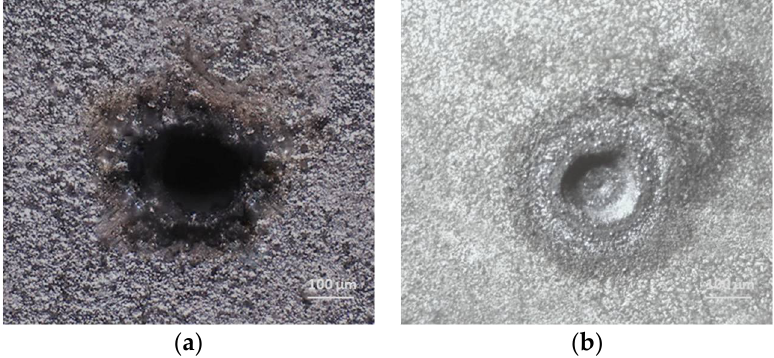
Figure 10. Micromachined cavities in the smart material using the LA-LBMM process under ( a ) distilled water, and ( b ) ethylene glycol.